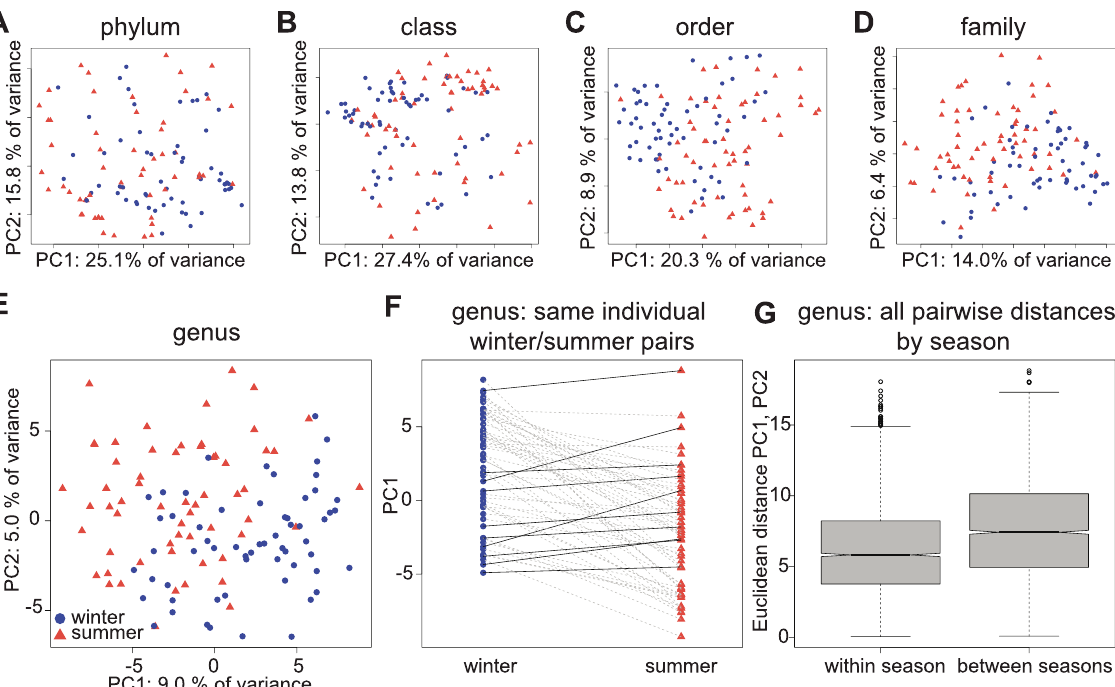
Figure 2. Consistent temporal shifts observed in microbiome composition. Principal components analysis (PCA) of data obtained from samples collected in the summer (red triangle) and winter (blue circle), at the phylum (A), class (B), order (C), family (D), and genus (E) level across samples. F) Individual shifts in microbiome composition along PC1 (y-axis). Data from the same individual across seasons is connected by a line (gray lines represent individuals showing seasonal trend, black lines highlight individuals showing the opposite trend). G) The average pairwise distance along the PC1/PC2 plane is shorter where points are from the same season than points between seasons (t-test P =3.38 6 10 2 78 ), supporting seasonal clustering along the first two principle components.